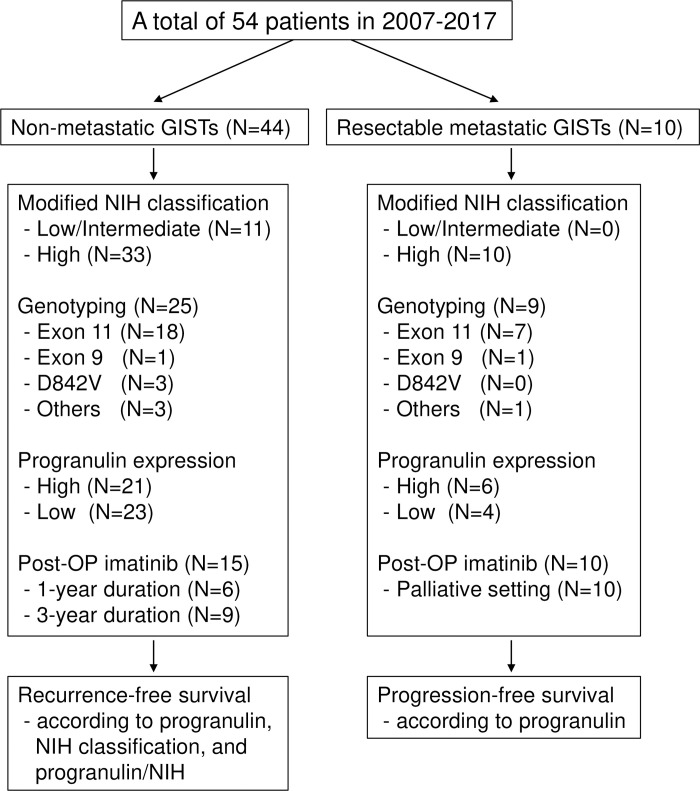
Flowchart of patients and clinicopathological features.